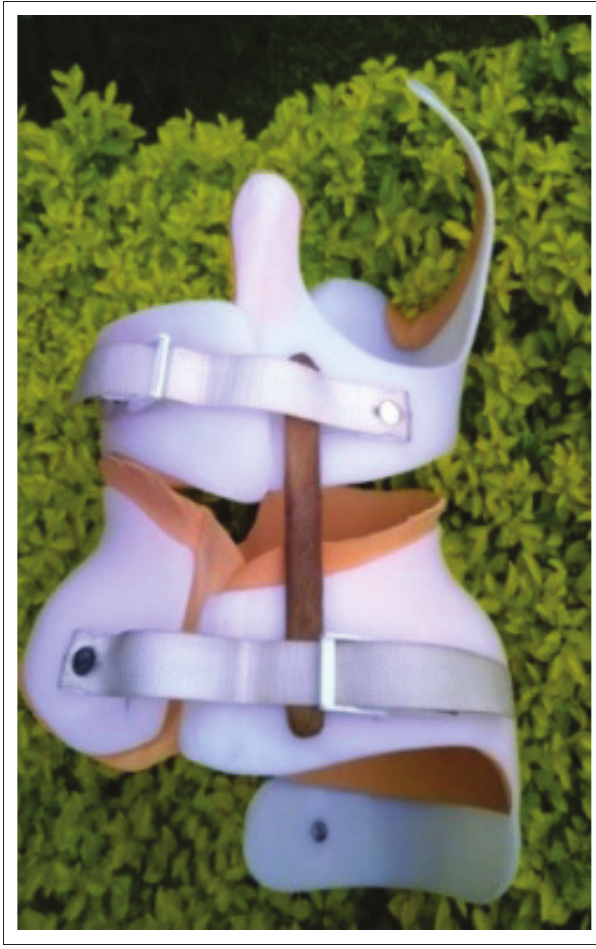
FIGURE 4: Spinal Orthosis molded on a plaster of Paris (POP) positive